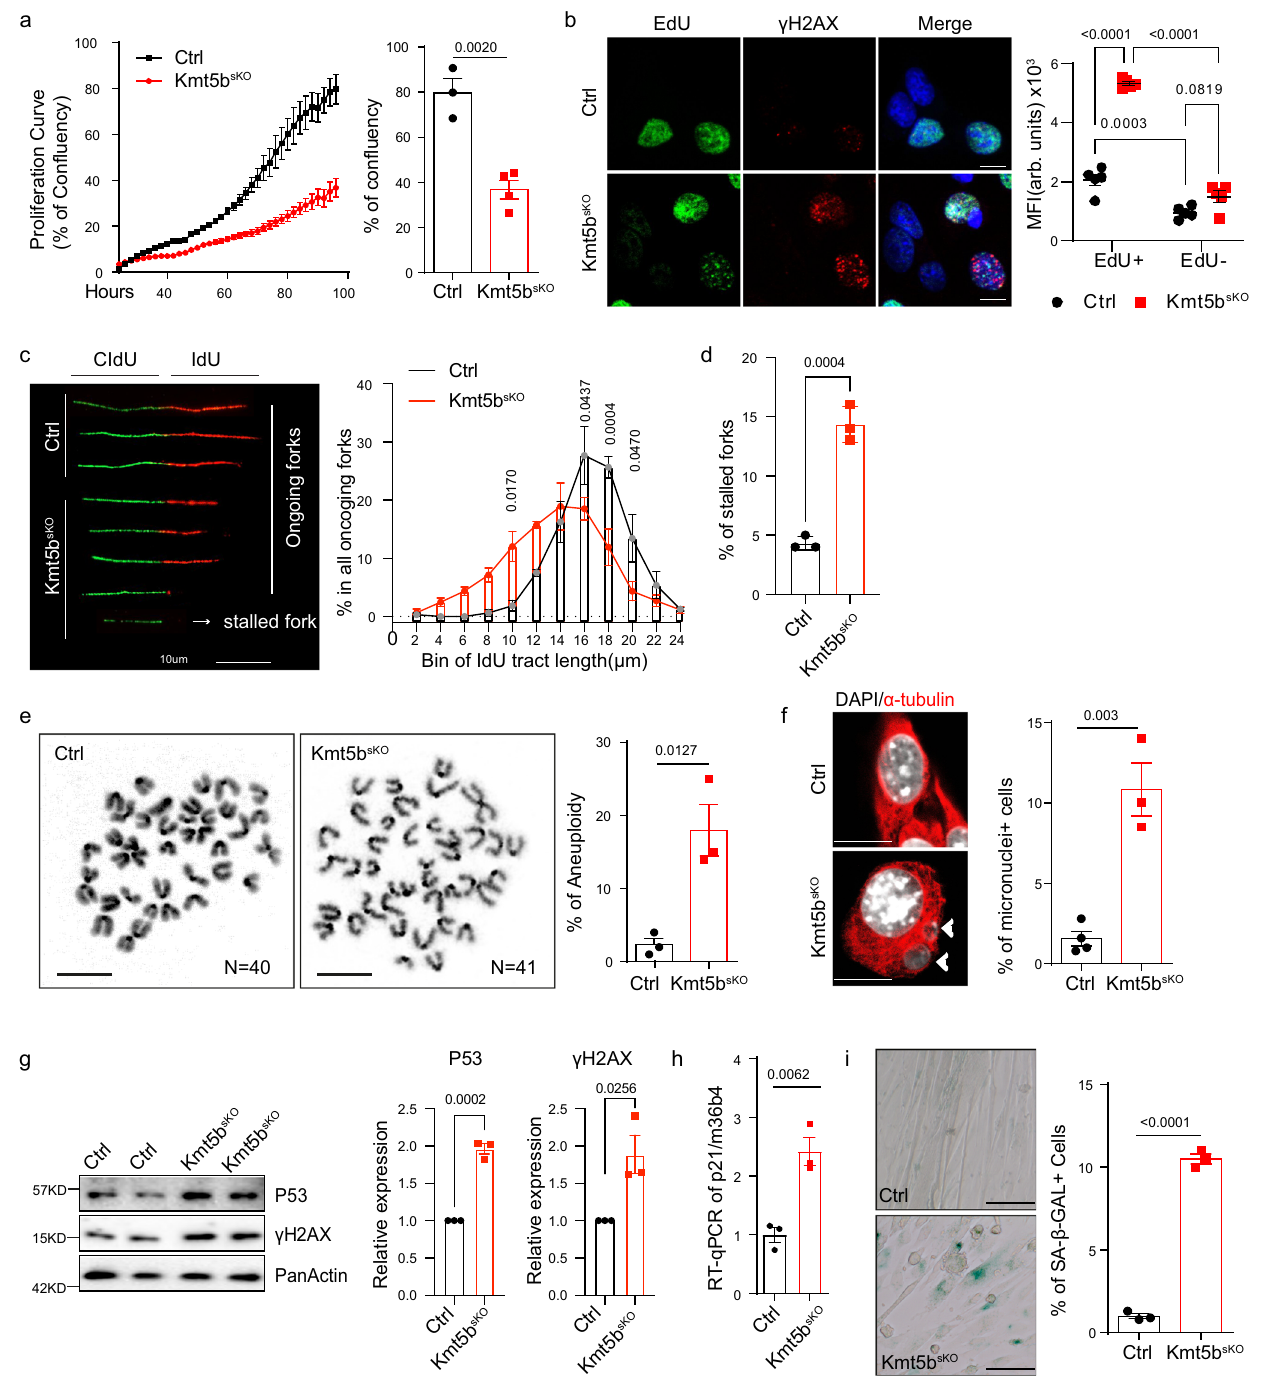
CtrlN=41N=40Ctrl P53 PanActinγH2AX Fig. 1 | Kmt5b prevents replication stress and genome instability in pro- Quanti fi cation of aneuploid MuSCs is on the right. f Immuno fl uorescence staining liferating MuSC. a Proliferation rate of Ctrl ( n =3 mice) and Kmt5b sKO ( n =4 mice) for α -tubulin/DAPI showing Kmt5b sKO MuSCs with micronuclei (indicated by MuSCs quanti fi ed during time lapse imaging. Con fl uency of Ctrl and Kmt5b sKO arrowheads). Scale bar: 10 μ m. Percentage of Ctrl ( n =3 mice) or Kmt5b sKO ( n =4 MuSCsatthelasttimepointisontheright. b Immuno fl uorescencestainingforEdU mice) MuSCs with micronuclei is on the right. g Western blot analysis of pP53 and γ H2AX in Ctrl and Kmt5b sKO MuSCs after 4 days in culture. Pan-Actin was used as and γ H2AXin Ctrl and Kmt5b sKO MuSCsafter4daysinculture( n =4mice).DNAwas stained by DAPI. Scale bar: 10 μ m. Median of fl uorescence intensity (MFI, arbitrary loading control. Band intensities were quanti fi ed, corresponding plots are shown units (arb. units)) of γ H2AX/EdU + and γ H2AX/EdU − MuSCs are shown on the right. ontheright( n =3mice). h RT-qPCRanalysesof p21 expressionin Ctrl and Kmt5b sKO MuSCs( n =3mice). 36b4 wasusedasreferencegene. i SA- β -GALstainingof Ctrl and Data are shown as mean ± SEM; Two-way ANOVA. c Representative images of DNA fi bers labeled with CIdU and IdU. Scale bar: 10 µ m. Quanti fi cation of fork progres- Kmt5b sKO MuSCsafter7-daysinproliferationmedium( n =3mice).Scalebar:20 μ m. Quanti fi cation of SA- β -GAL positive cells is on the right. Data are shown as sion in Ctrl and Kmt5b sKO MuSCs is shown on the right ( n =3 mice). Data are shown as mean ± SEM; Two-way. d Percentage of stalled folks in Ctrl and Kmt5b sKO MuSCs mean ± SEM. Unpaired two-sided Student ’ s t -tests were employed for all panels in all fi bers ( n =3 mice). e Images of DAPI-stained metaphase chromosome except for ( b ) and ( c ). Source data are provided in the Source Data fi spreadings prepared from Ctrl and Kmt5b sKO MuSCs ( n =3 mice). Scale bar: 10 µ m.